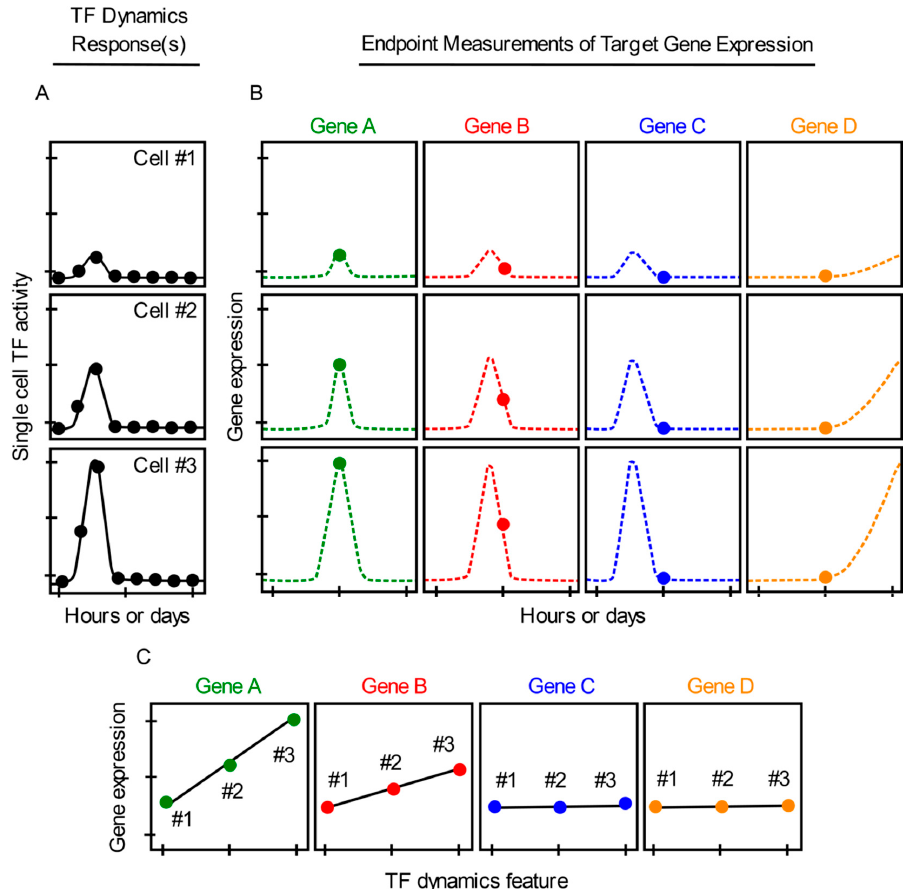
Figure 2. Continuous measurements of TF dynamics and endpoint measurements of gene expression in the same single cells using smRNA-FISH or scRNA-seq. ( A ) Single cell TF dynamic responses (cells #1–3) imaged continuously (dots) after a hypothetical cell activation. ( B ) Single-cell smRNA-FISH or scRNA-seq endpoint measurements (dots) of gene expression levels for hypothetical genes A–D induced by the TF dynamics in cells #1–3 ( A ). ( C ) Graphs depicting positive correlation (genes A, B) and spurious lack of correlation (genes C, D) (due to incomplete data) between TF dynamics and single cell gene expression. Dotted lines represent unsampled measurements.